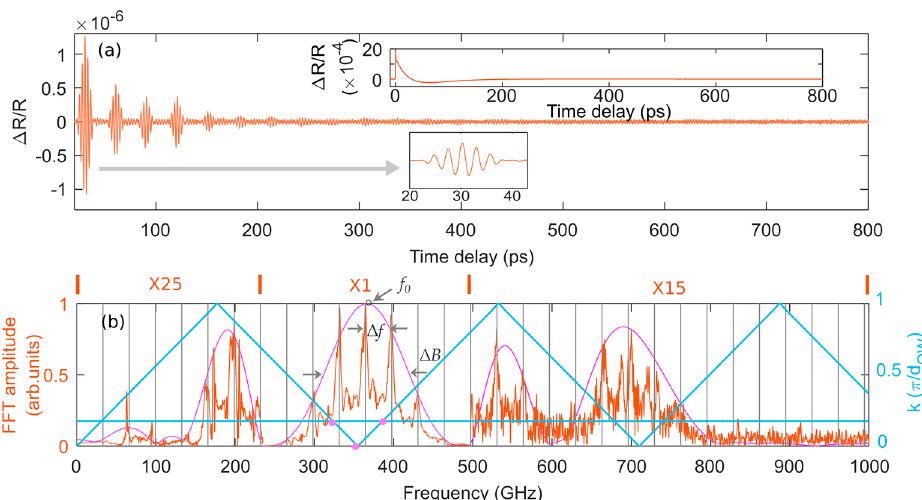
Figure 2. ( a ) Coherent acoustic phonon wave-packets after background removal. Top inset: the original time trace. Bottom inset: zoom in of the wave-packet at around 30 ps. ( b ) Acoustic spectrum and dispersion relation in GaAs/In 0.27 Ga 0.73 As SL. The brown line represents the acoustic spectrum. The magenta curve depicts the FFT of the wave-packet at 30 ps. The z-like blue line represents the dispersion relation and the horizontal blue line indicates the wavevector position k = 2 q probeGaAs/InGaAs . The vertical gray lines are spaced by the comb spacing of 33.15 GHz.